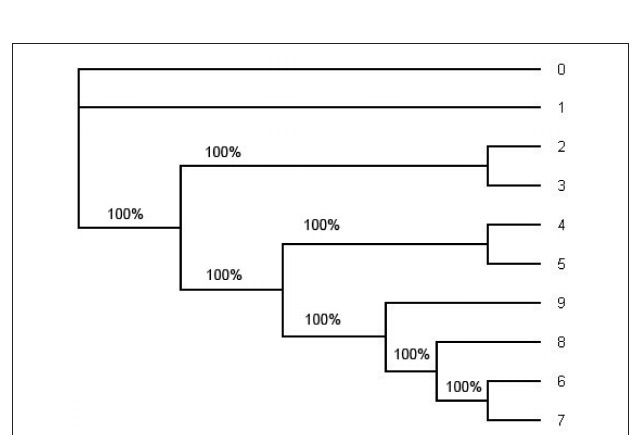
Figure 4 | The consensus tree estimated by the software MrBayes under HKY from the whole alignment (including position 1 through position 1505). This is an unrooted tree. The number in each split represent the probability of the split. The consensus tree estimated under the GTR + Γ also has the same tree topology but it has smaller probabilities of some splits. Note that the tree topology of the consensus tree is the same as the tree topology of the ML tree in Figure 5 and the tree topology in Figure 1